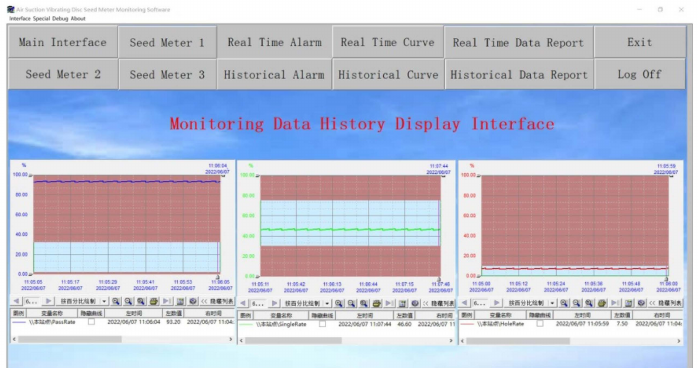
Figure 14. History curve interface of seed meter running status